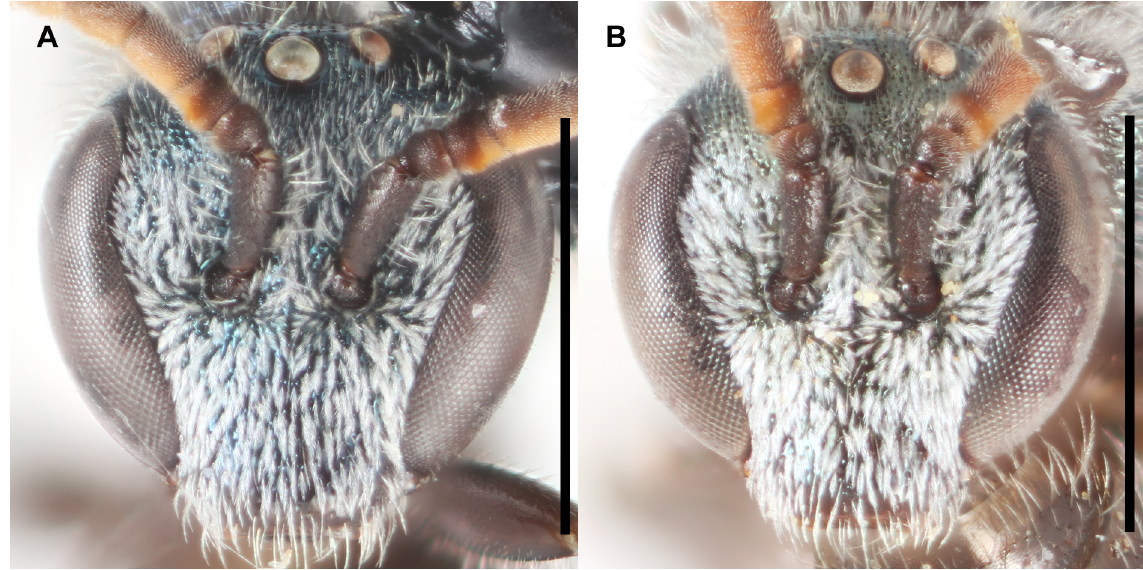
Fig. 118. Face. A . Lasioglossum puteulanum Gibbs, 2009, ♂, slightly longer. B . L. tegulare (Robertson, 1890), ♂, slightly shorter. Scale bars = 1 mm.